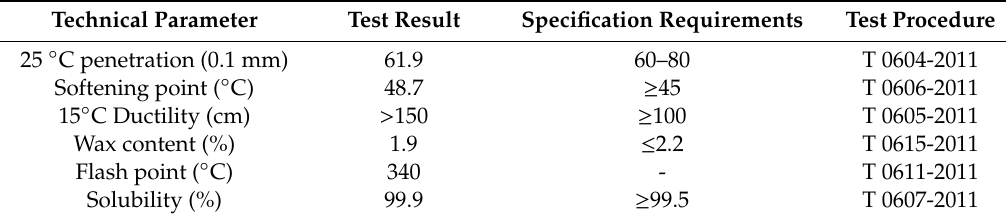
Table 1. Technical parameters of the asphalt.